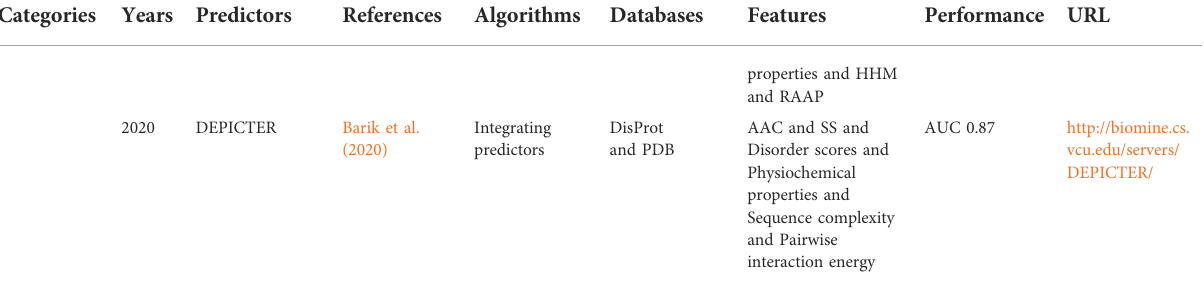
TABLE 2 ( Continued ) Summary of intrinsically disordered protein-protein interaction sites